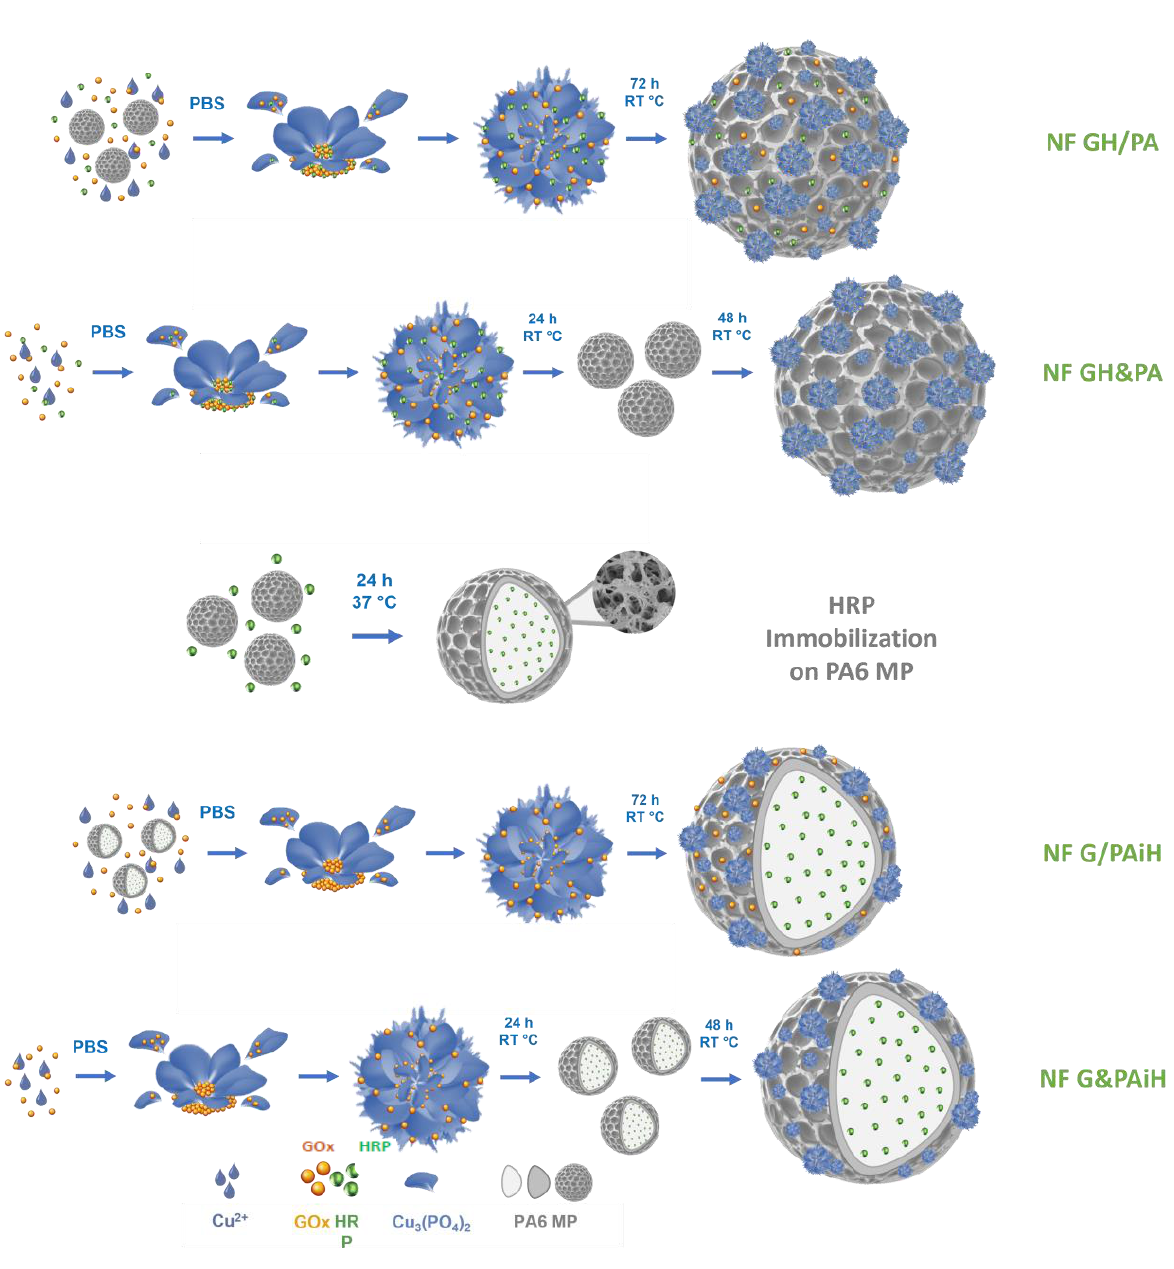
Figure 1. Schematic presentation of the design strategy for assembling NF-decorated porous PA6 microparticles carrying the GOx/HRP enzyme dyad. PBS = phosphate buffer saline; RT = room temperature (20–23 °C).